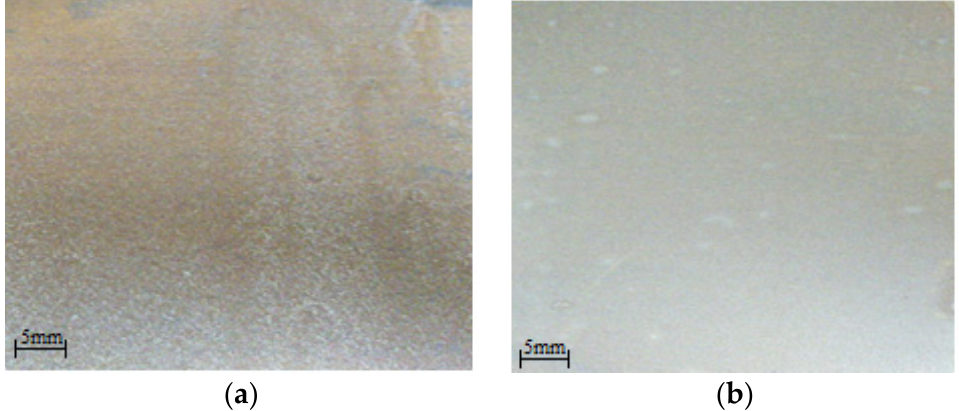
Figure 6. The effect of the content of PEPA on the appearance of the coating; ( а ) without surfactants; and ( b ) with a PEPA of 0.25 g/dm 3 .